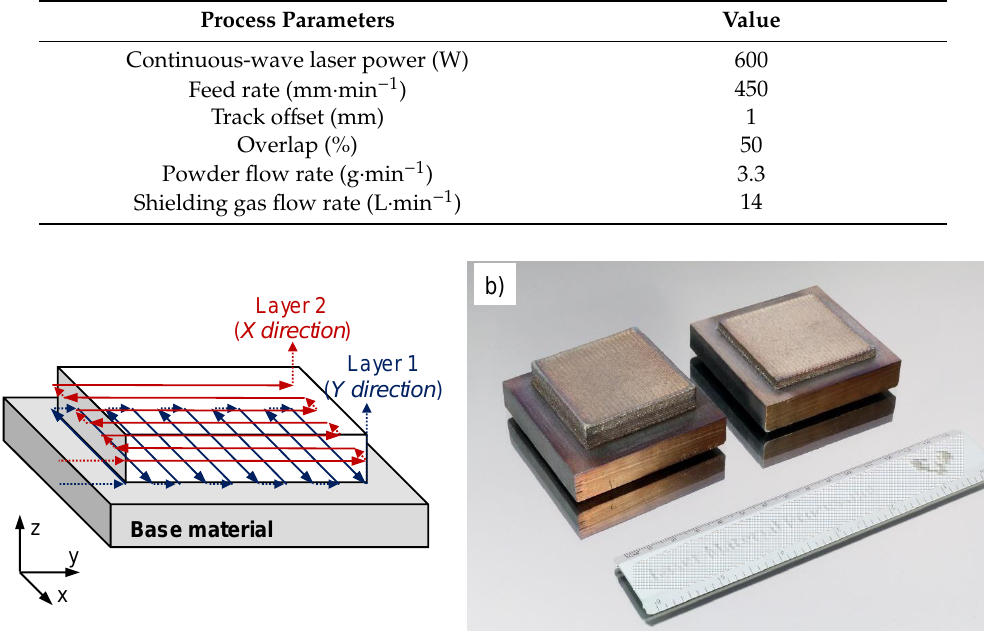
Figure 1. Schematic of the Directed Energy Deposition (DED) process ( a ) and ( b ) photograph of the manufactured AISI H13 specimens.